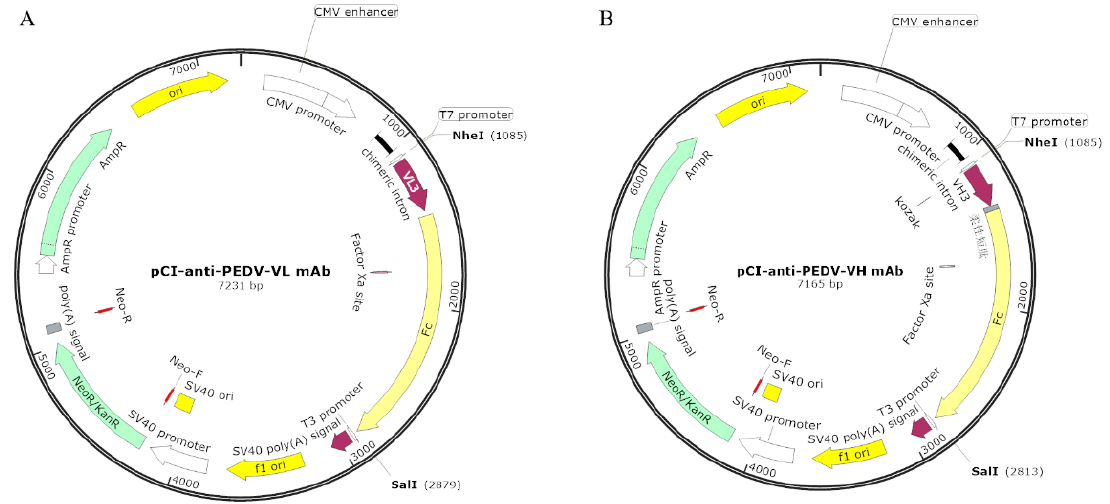
Figure 1. The vector map of eukaryotic expression vectors. ( A ) pCI-anti-porcine epidemic diarrhea virus (PEDV)-VL mAb. ( B ) pCI-anti-PEDV-VH mAb.